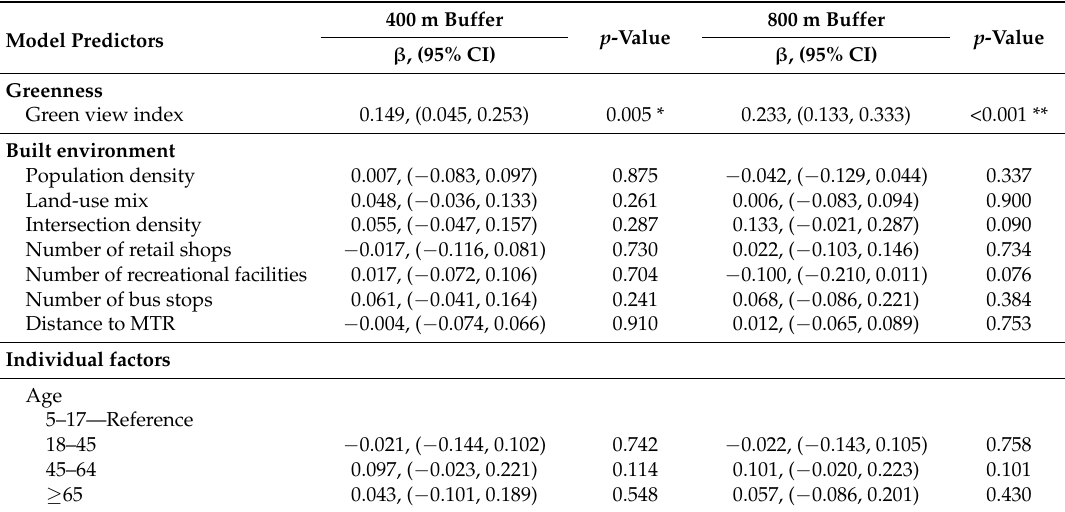
Table 3. Multilevel linear regression analysis for the relationship between greenness and built environment and individual factors, and walking time (in minutes) in level 2; n =